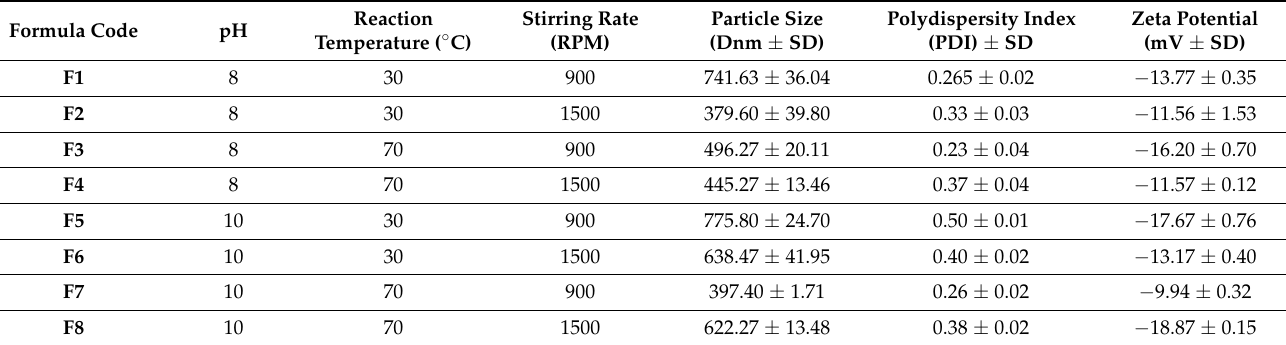
Table 2. Experimental data values for particle size, polydispersity index, and zeta potential obtained by 2 3 Full factorial design. Data are shown as mean ± standard deviation. Results are averages of two independent experiments with three replicates